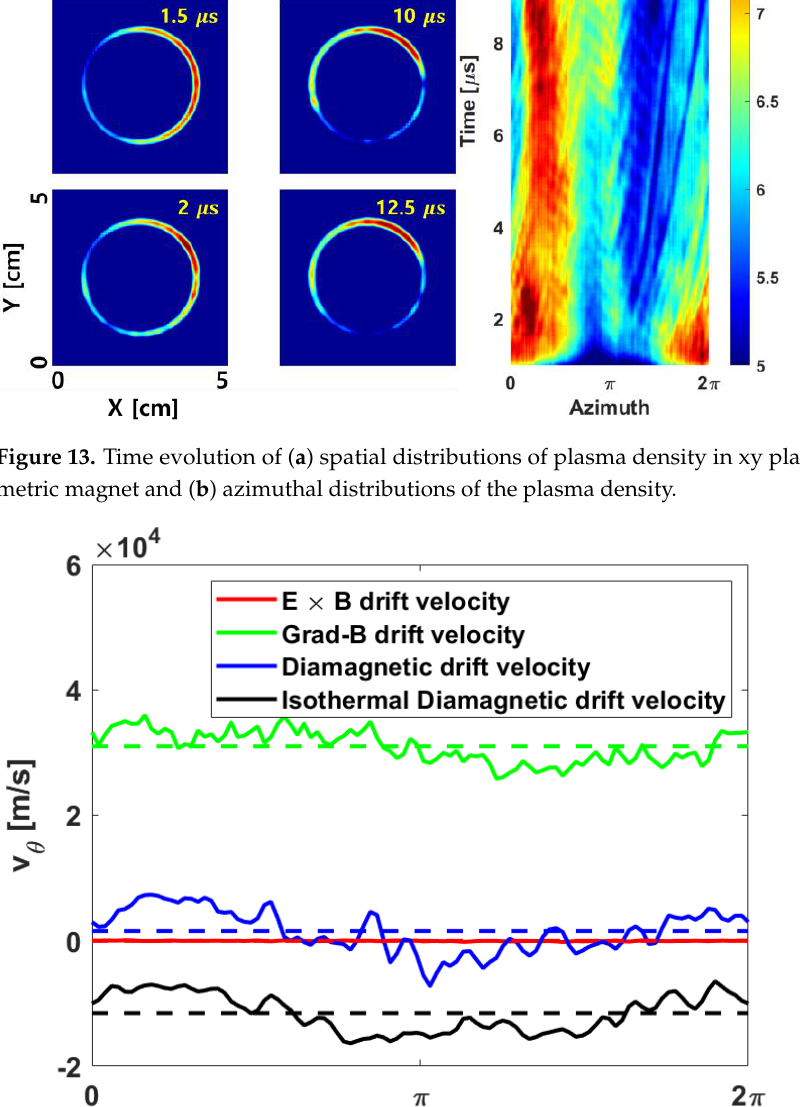
Figure 14. Azimuthal drift velocities were measured at z = 3.125 mm and r = 1.6 cm for E × B (red), grad-B (green), and diamagnetic (blue) drift, respectively. The black line is for the diamagnetic drift under the assumption of an isothermal plasma without a temperature gradient. Dashed lines indicate the mean values of each drift velocity.